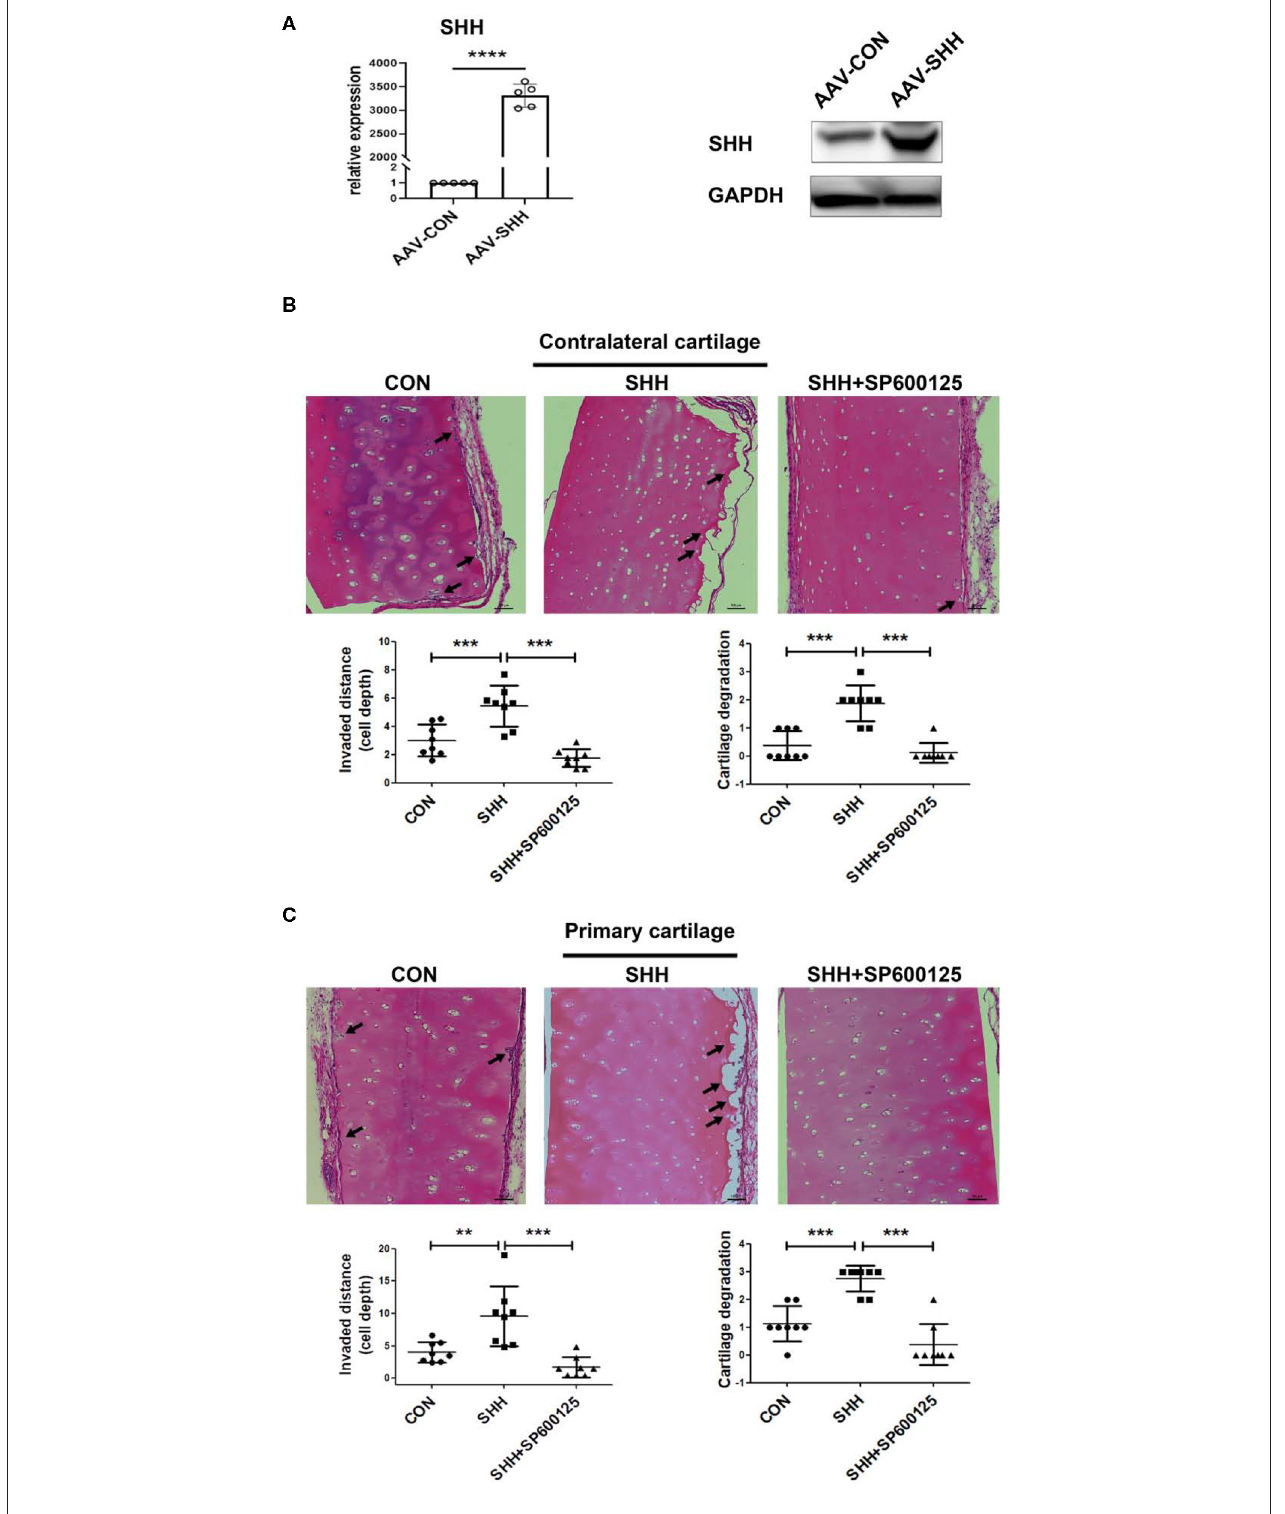
FIGURE 6 | Inhibition of JNK alleviates FLSs invasiveness in vivo promoted by SHH. The invasiveness of FLSs in vivo was evaluated using a humanized synovitis animal model. SCID mice were used in the experiments ( n = 5 in each group). A cartilage-sponge complex without FLSs was implanted under the left flank skin of